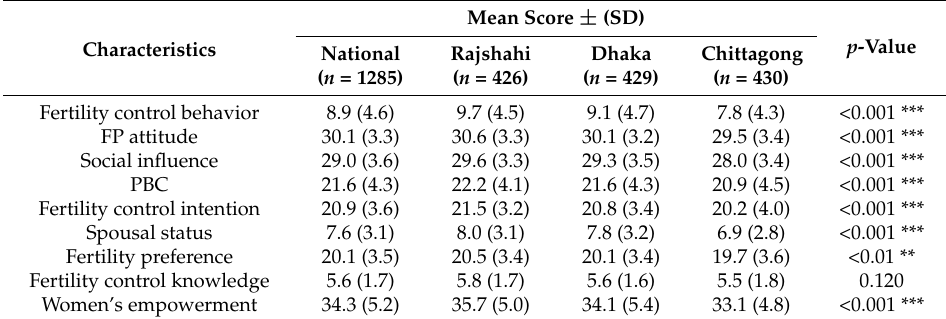
Table 5. Regional variations in fertility control behavior and its related factors by Kruskal–Wallis and one-way ANOVA test ( n =